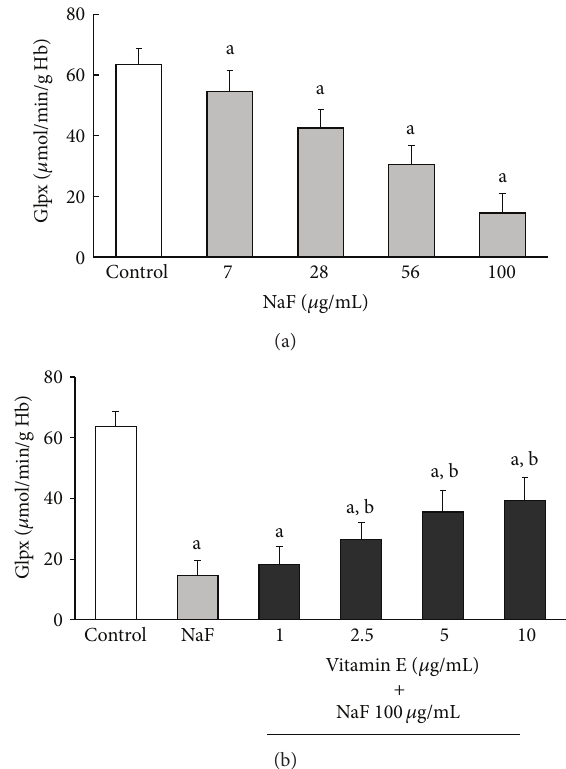
Figure 4: GlPx activity in erythrocytes incubated under the same conditions described in Figure 2. The results are expressed as the mean ± standard deviation of five independent experiments, taking two samples per experiment and performing the determinations in triplicate. a 𝑃 < 0.05 compared with the control group; b 𝑃 < 0.05 compared with the group incubated with only 100 𝜇 g/mL